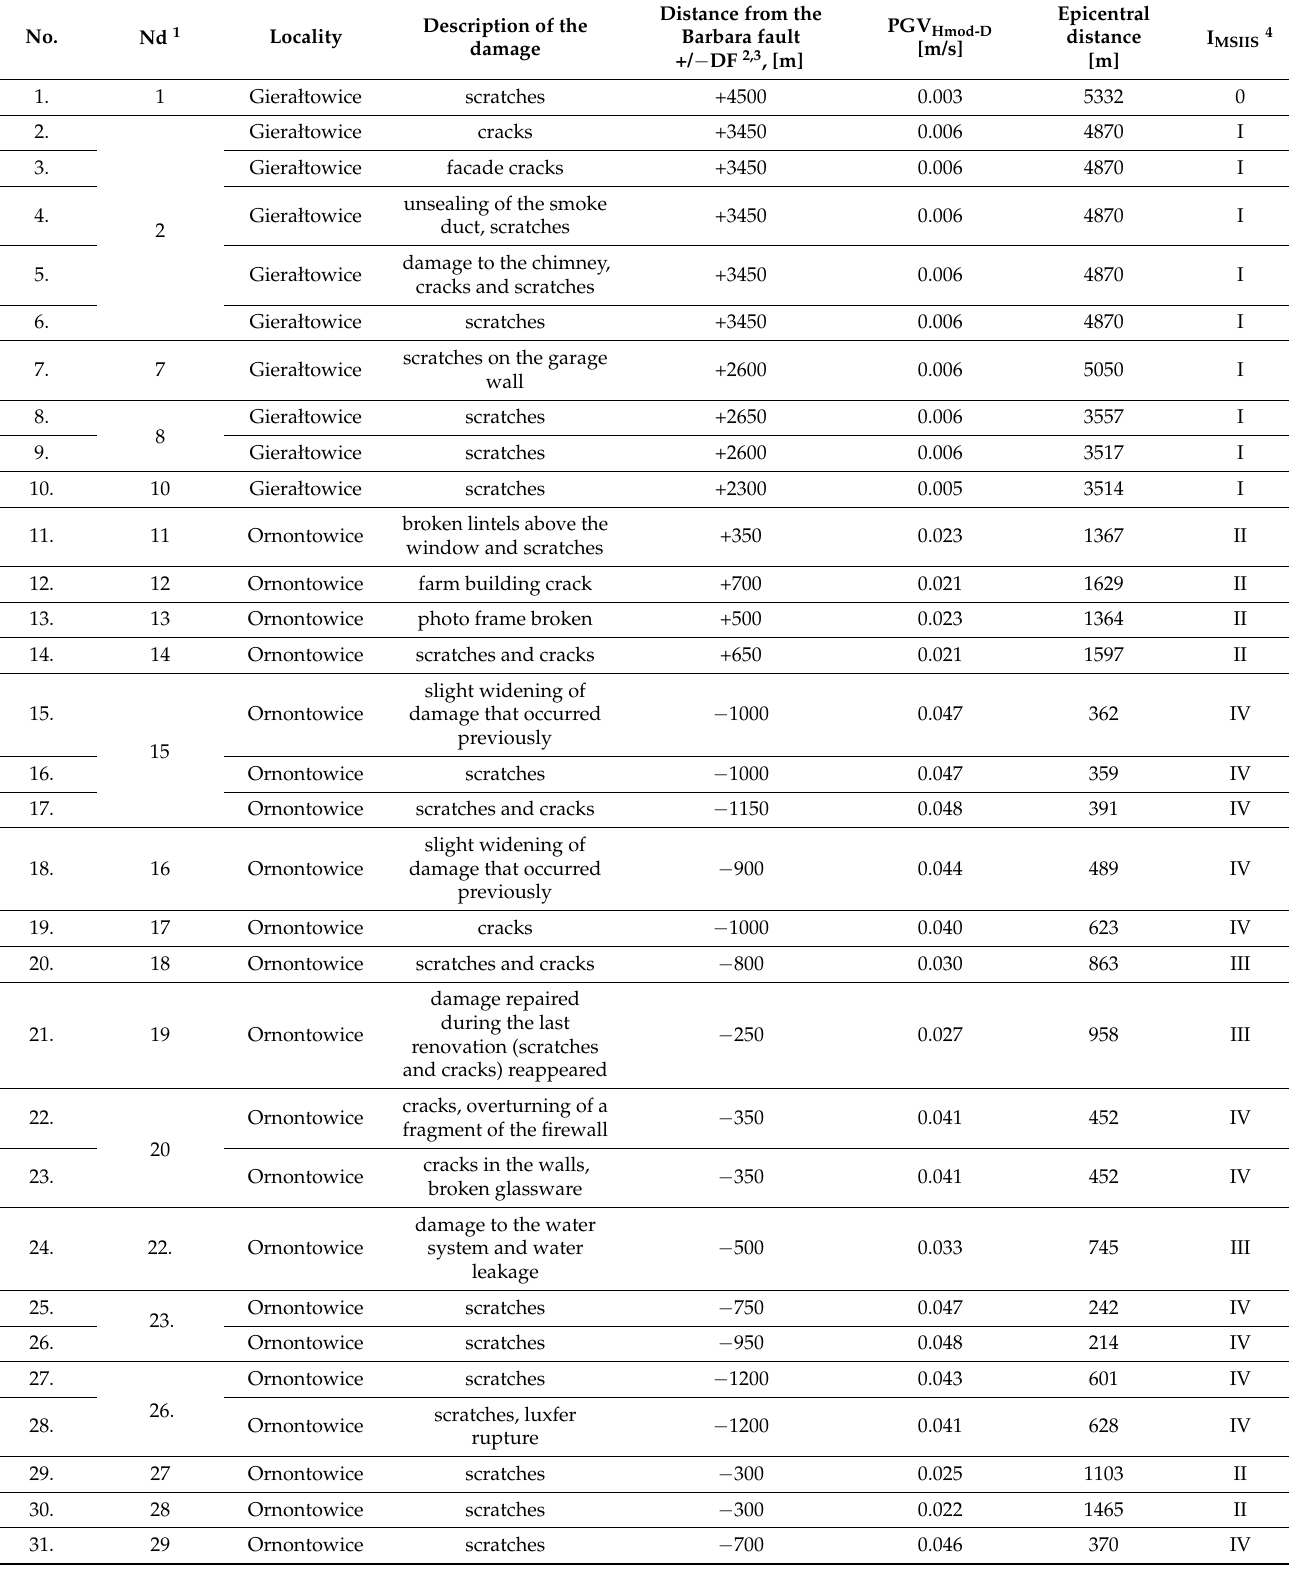
Table 4. Damage to buildings after the tremor of 8 November 2018 relative to the hanging wall of the Barbara fault.